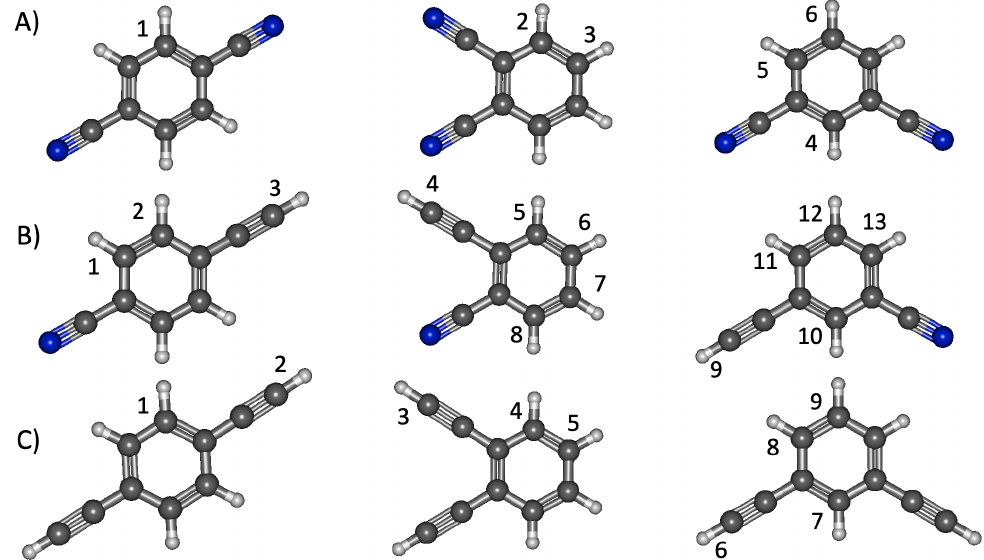
Figure 1. The optimized structure of the benzene-class molecules with numbered positions of deprotonation. ( A ) dicyanobenzene, ( B ) cyanoethynylbenzene, ( C )